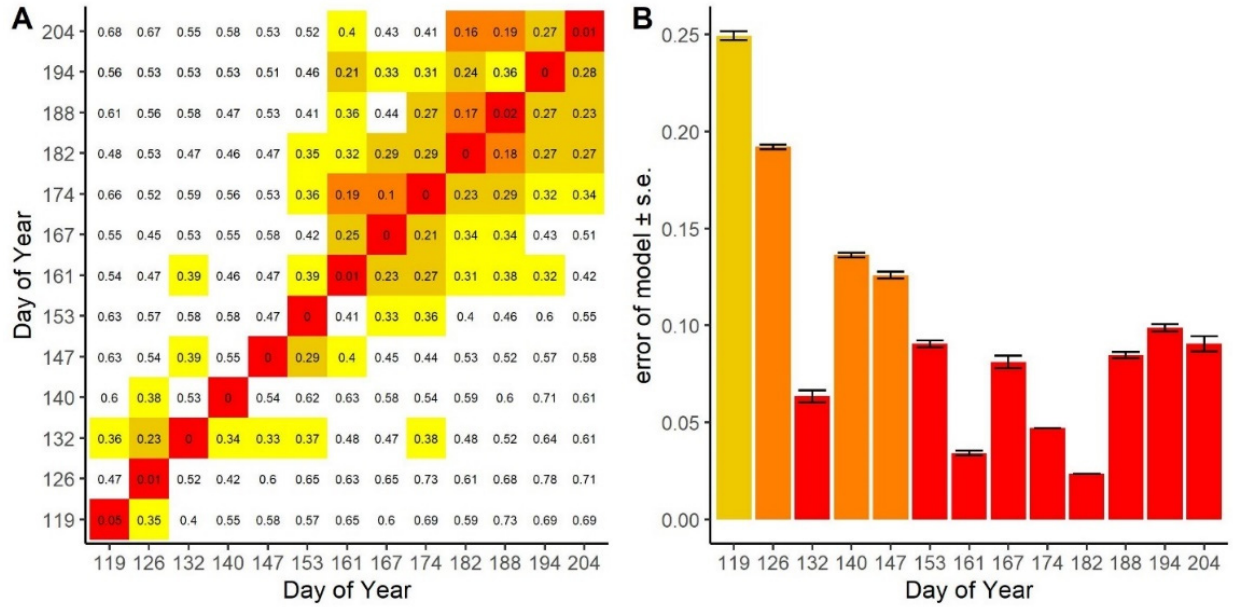
Figure 6. ( A ) Confusion matrix of the mean errors of the 10 model runs that were trained using data from single sampling dates and tested using data that were collected on the other sampling dates. The temporal dependence of the data was higher after DoY 153. ( B ) The error of the model that was trained using data from all sampling dates and tested using data from single sampling dates. The error bars show the standard error of the mean model error after 10